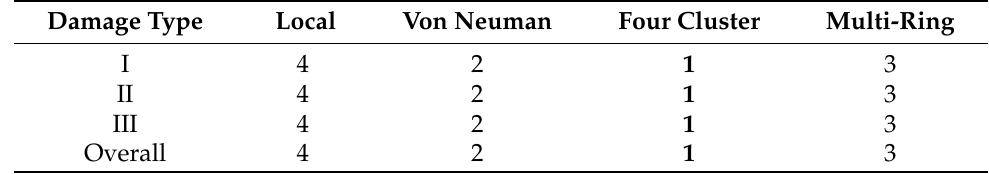
Table 6. The average rank of mean iterations for the four best performing